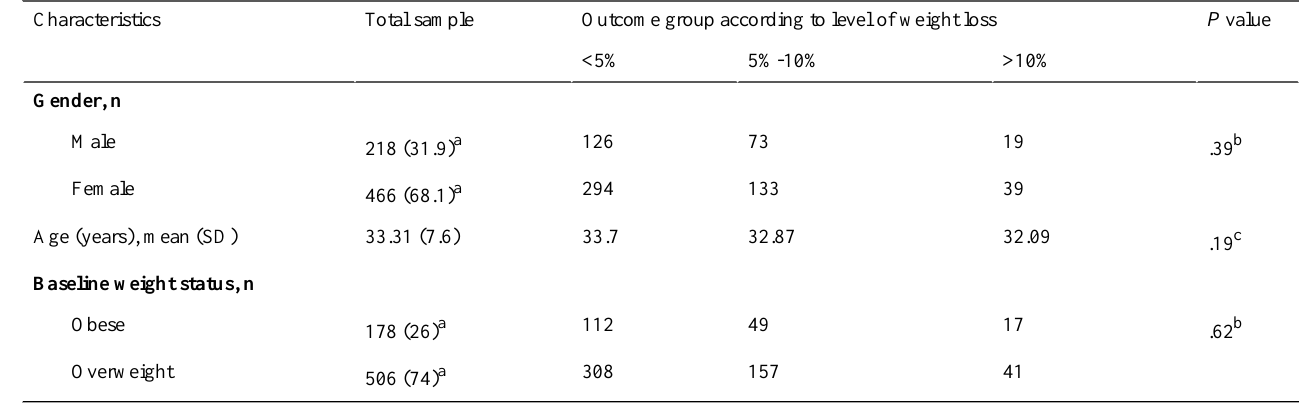
Table 1. Participant characteristics for the total sample and according to outcome